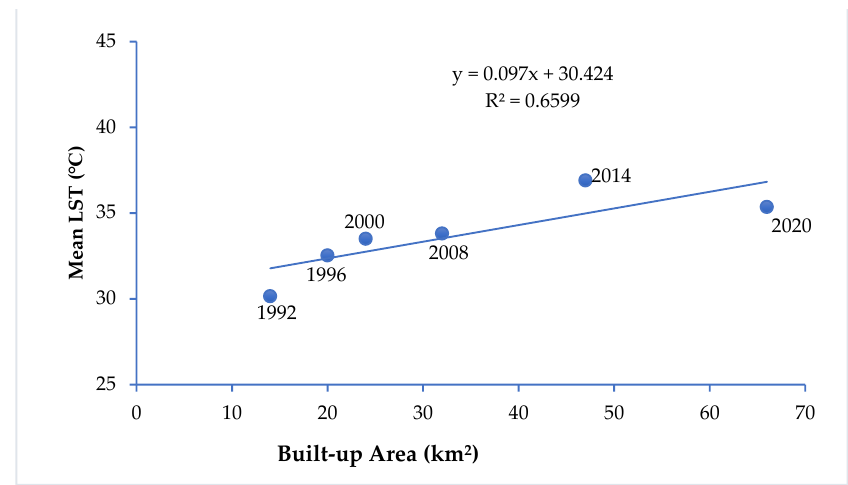
Figure 9. Expansion in Built-up land and LST in ( a ) 1992, ( b ) 1996, ( c ) 2000, ( d ) 2008, ( e ) 2014, ( f ) 2020. The symbol ( ) indicates the position of Pilot Balloon Observatory (PBO).